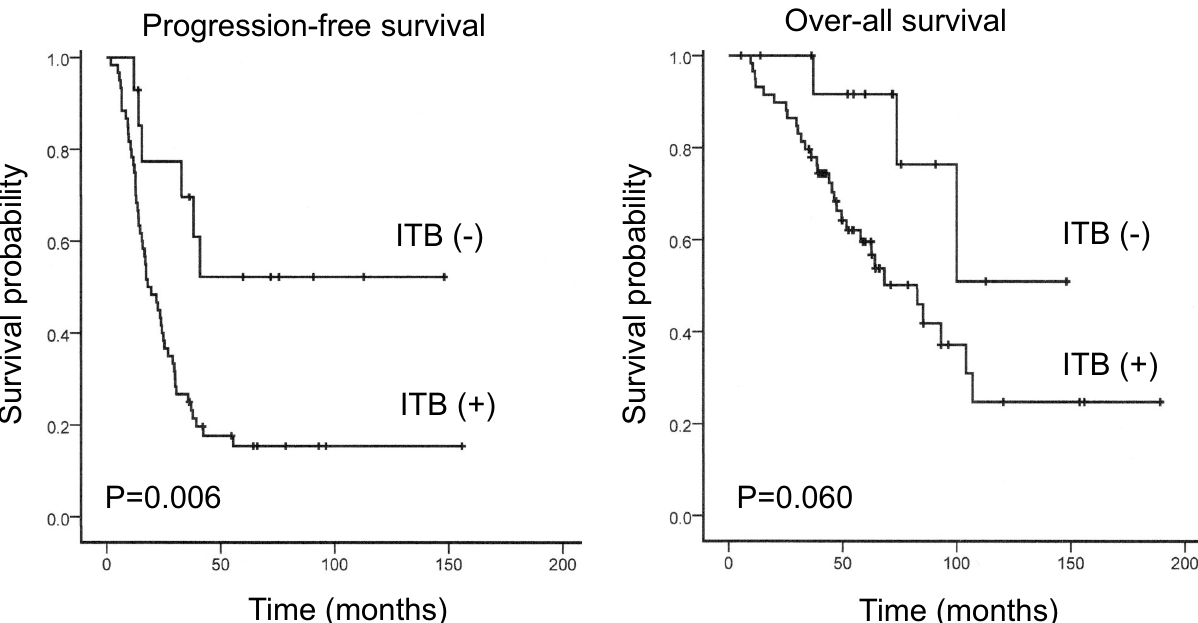
Figure 3. Kaplan–Meier survival analyses of the progression-free and over-all survivals in patients with high- grade serous ovarian carcinoma with and without intra-tumoral budding (ITB).